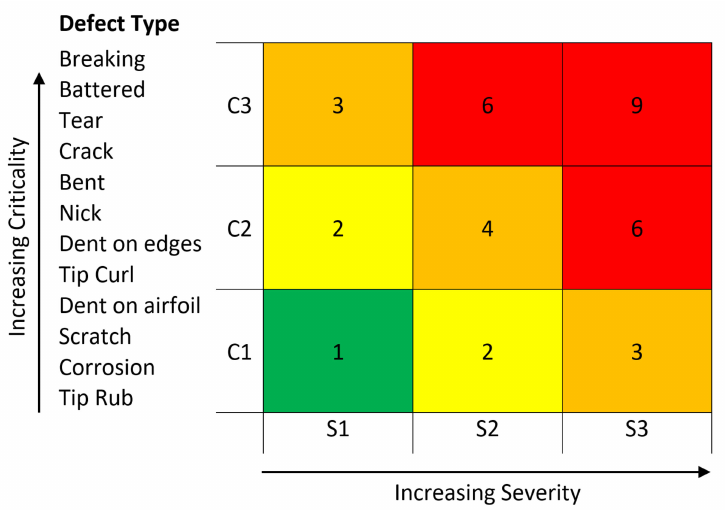
Figure 7. Defect criticality and severity matrix if scales are